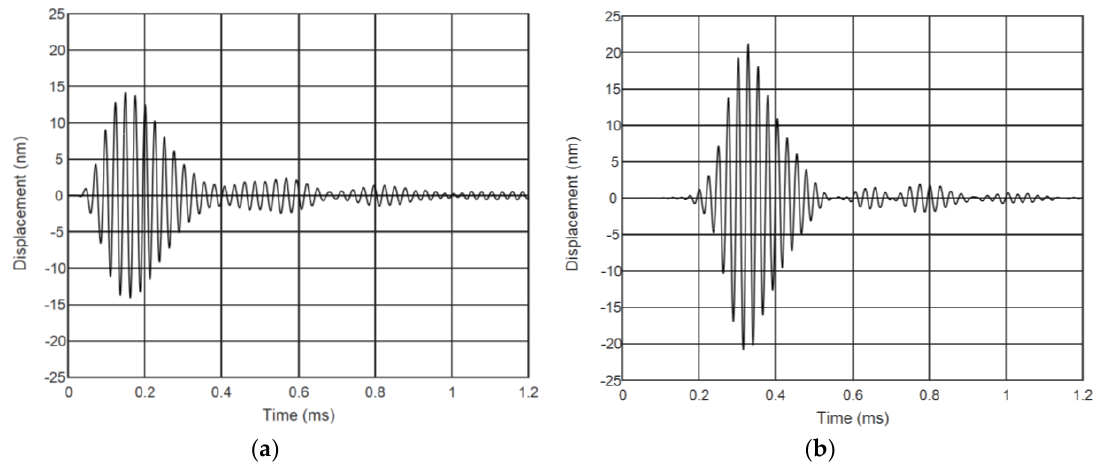
Figure 16. Measured normal displacements ξ of the plastic film excited by the 8 element air-coupled array at L = 1 mm from the last array element: ( a ) all array elements are excited simultaneously; and ( b ) successive (phased) excitation of the array elements with the optimized delay times.